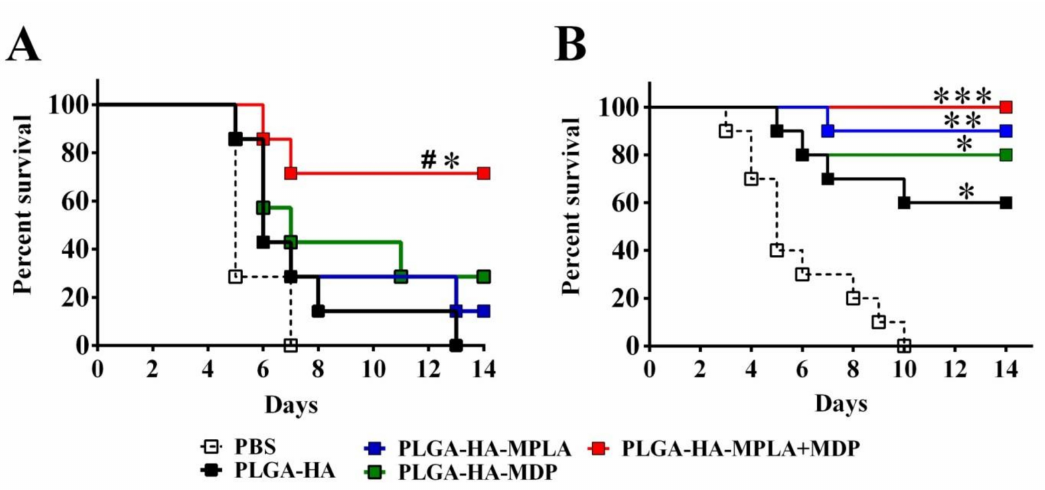
Figure 9. PLGA NPs containing both MPLA and MDP led to a stronger protection in mice than NPs containing individual PRR agonists. Kaplan–Meier survival curves of mice i.m. immunized three times with ( A ) 1 dose (1 mg / mouse, n = 8 per group) or ( B ) 2 doses (2 mg / mouse, n = 10 per group) of PLGA NPs: PLGA-HA, PLGA-HA-MPLA, PLGA-HA-MDP, and PLGA-HA-MDP-MPLA. Non-immunized control mice received PBS. Two weeks after last immunization, mice were infected using a lethal dose (50LD50) of the A / California / 07 / 2009 (H1N1) strain virus. Mortality was monitored daily for 14 days post-challenge. # indicates a significant di ff erence ( p < 0.05) between PLGA-HA-MPLA + MDP and PLGA-HA vaccinated animals. Significant di ff erences between vaccinated with PLGA NPs and non-vaccinated animals are indicated by asterisks: * for p < 0.05 and ** for p < 0.01 and *** for p < 0.001 (log-rank